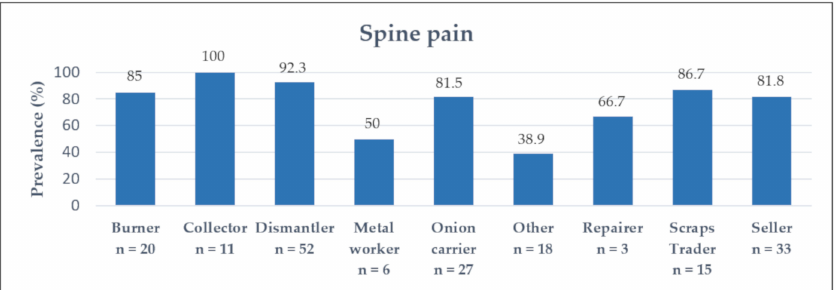
Figure 3. Frequency of back pain for all occupational groups (total number of workers n =